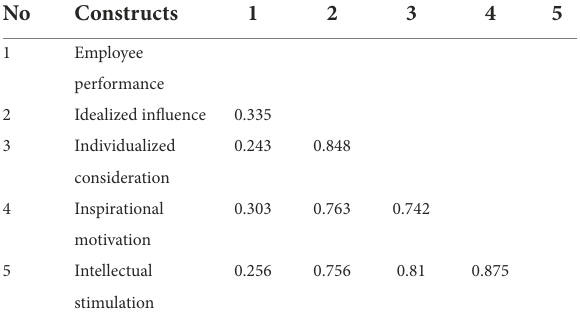
TABLE 3 Discriminant validity using HTMT